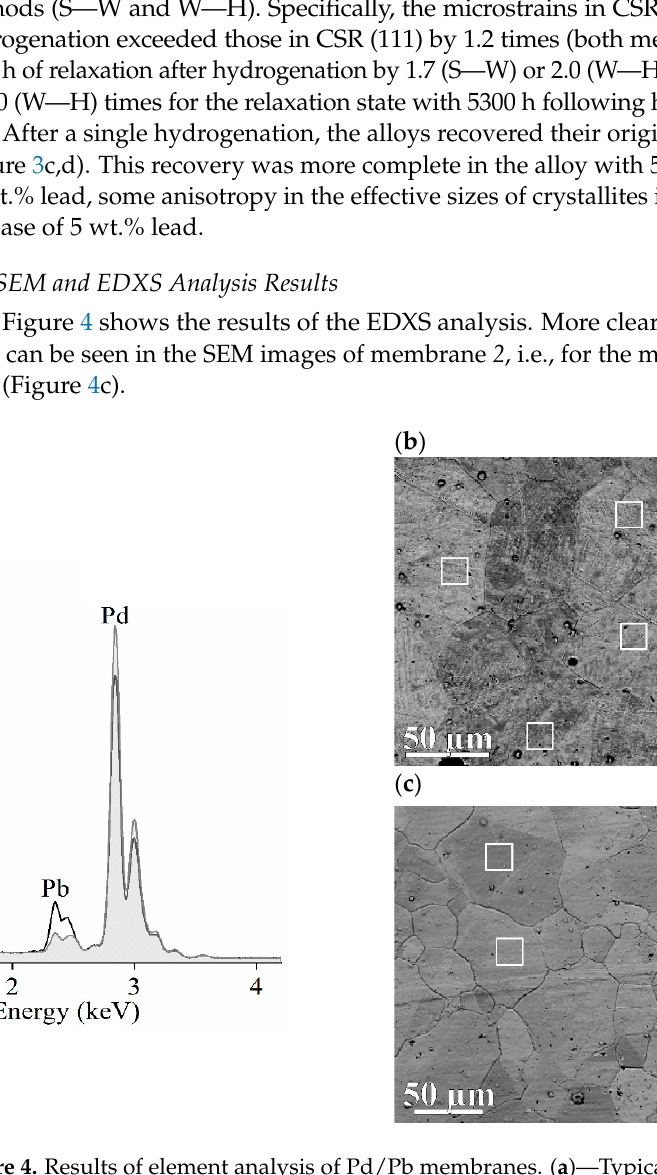
Figure 4. Results of element analysis of Pd/Pb membranes. ( a )—Typical EDXS spectrums of mem- branes; SEM images of the surface ( b )—membrane 1 ; ( c )—membrane 2 . The white frames indicate areas of EDXS analysis.